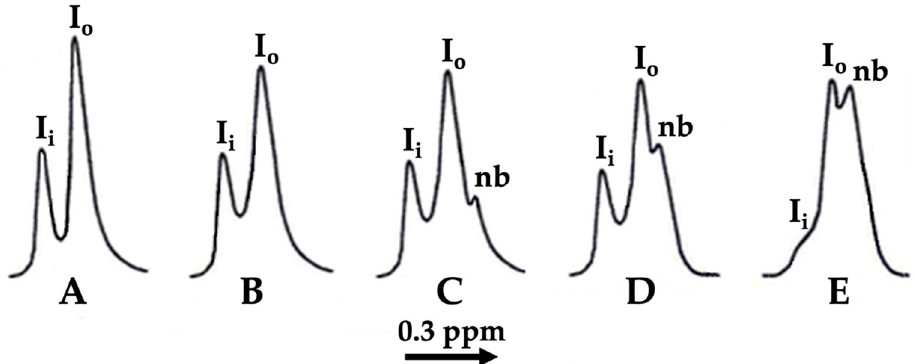
Figure 6. The 1 H-NMR spectra derived from the N + (CH 3 ) 3 groups of PC in the inner (I i ) and the outer (I o ) leaflets of unilamellar liposomes, mimicking the lipid composition of eukaryotic IMM, in the presence of K 3 [Fe(CN) 3 ]. ( A ) untreated liposomes; ( B – E ), respectively, liposomes treated with 1.2 × 10 − 4 M melittin, 1.2 × 10 − 4 M melittin and 1.2 × 10 –3 M ethanol, 1.2 × 10 − 4 M melittin and 1.2 × 10 − 3 M octanol, and 1.2 × 10 − 3 M melittin and 1.2 × 10 − 3 M ethanol. Total phospholipid concentration, 1.20 × 10 − 2 M.